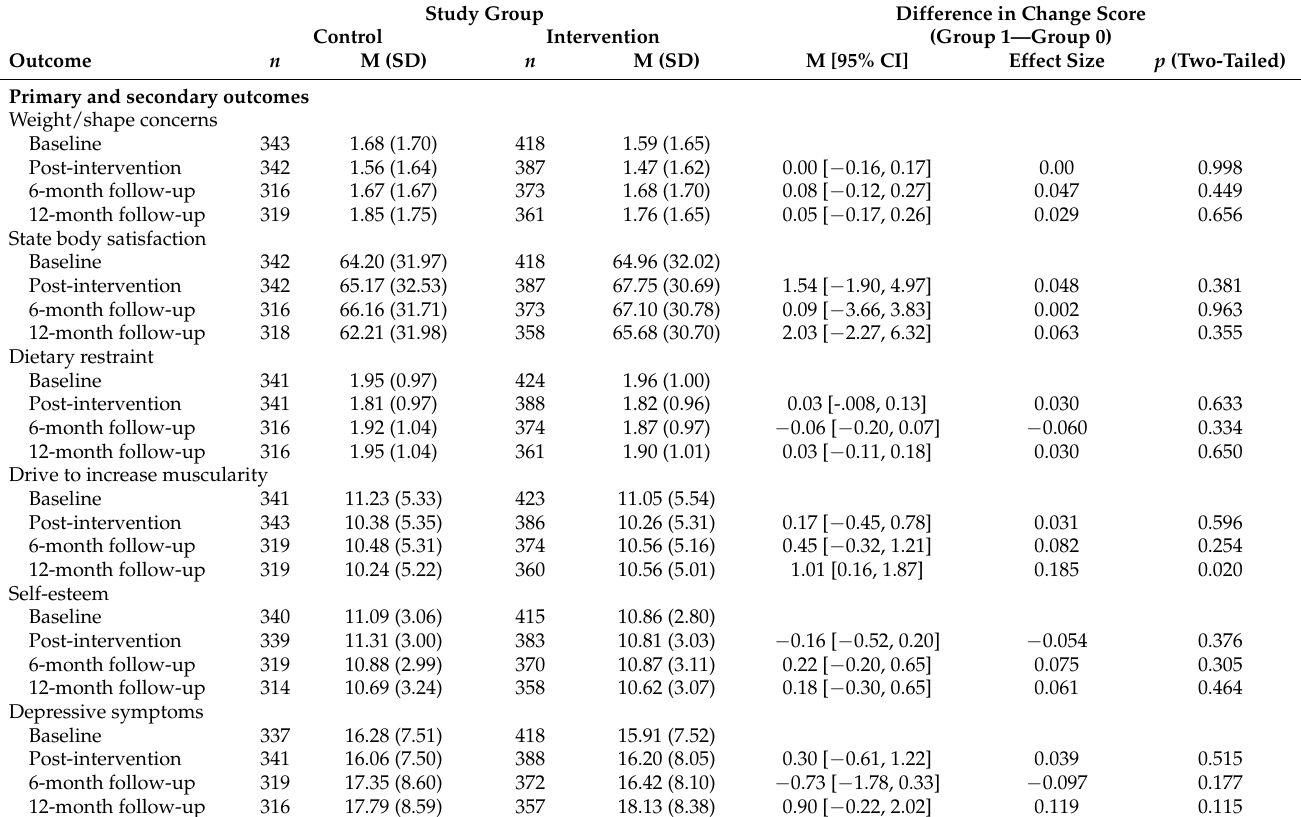
Table 3. Mean changes in study variables at post-intervention and 6- and 12-month follow-up for main analyses. Study